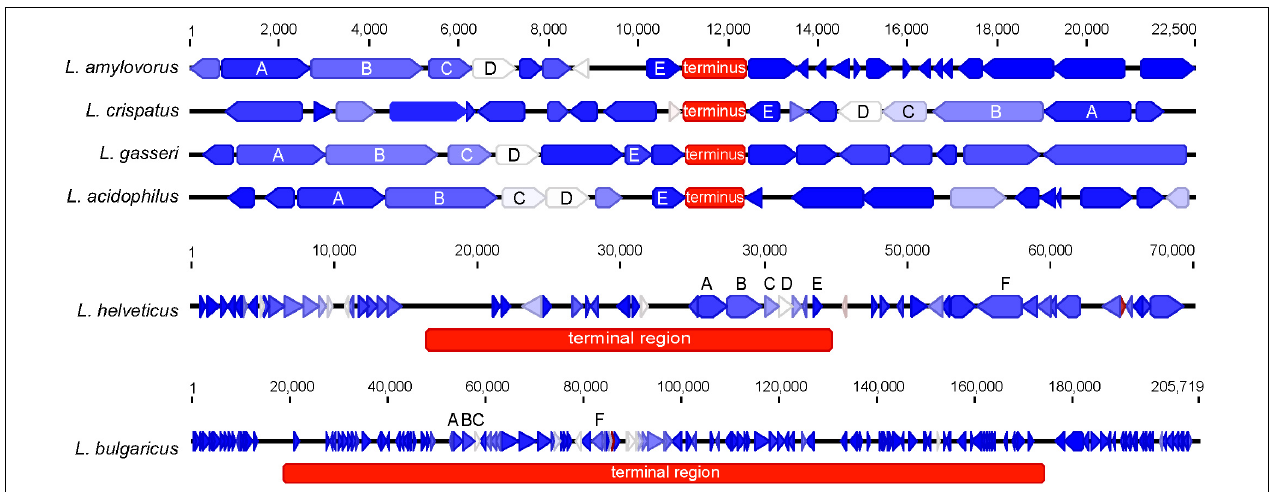
FIGURE 2 | Genetic architecture of the terminus or terminal region. The genetic locus of the terminus or terminal region for each organism is displayed. The genes are colored according to their expression level on a blue-white-red gradient with blue being lowly expressed and red being highly expressed; genes are displayed as arrows. The terminus is displayed as a red box; the color of the terminus does not correspond to expression. Conserved genes across all termini are labeled as follows: (A) (DNA topoisomerase IV subunit B), (B) (DNA topoisomerase IV subunit A), (C) (transcriptional regulator LysR), (D) (manganese-dependent pyrophosphatase), (E) (hypothetical membrane protein), and (F) (carbamoyl phosphate synthetase). The scale for L. amylovorus , L. crispatus, L. gasseri , and L. acidophilus is displayed at the top. Individual scales for L. helveticus and L. bulgaricus are displayed above their respective